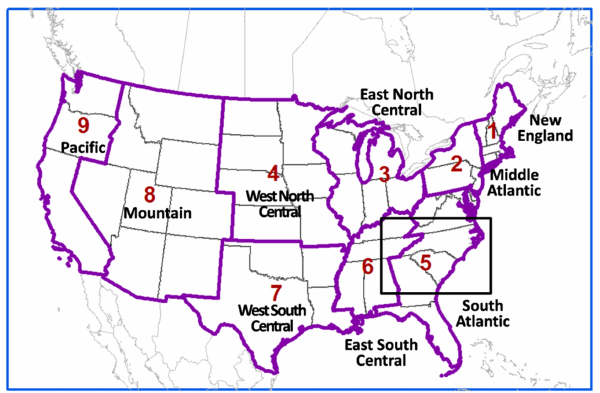
Figure 3. CMAQ 12km modeling domain (blue box) showing nine MARKAL emission projection regions (dark purple) and the South- east area (black box).